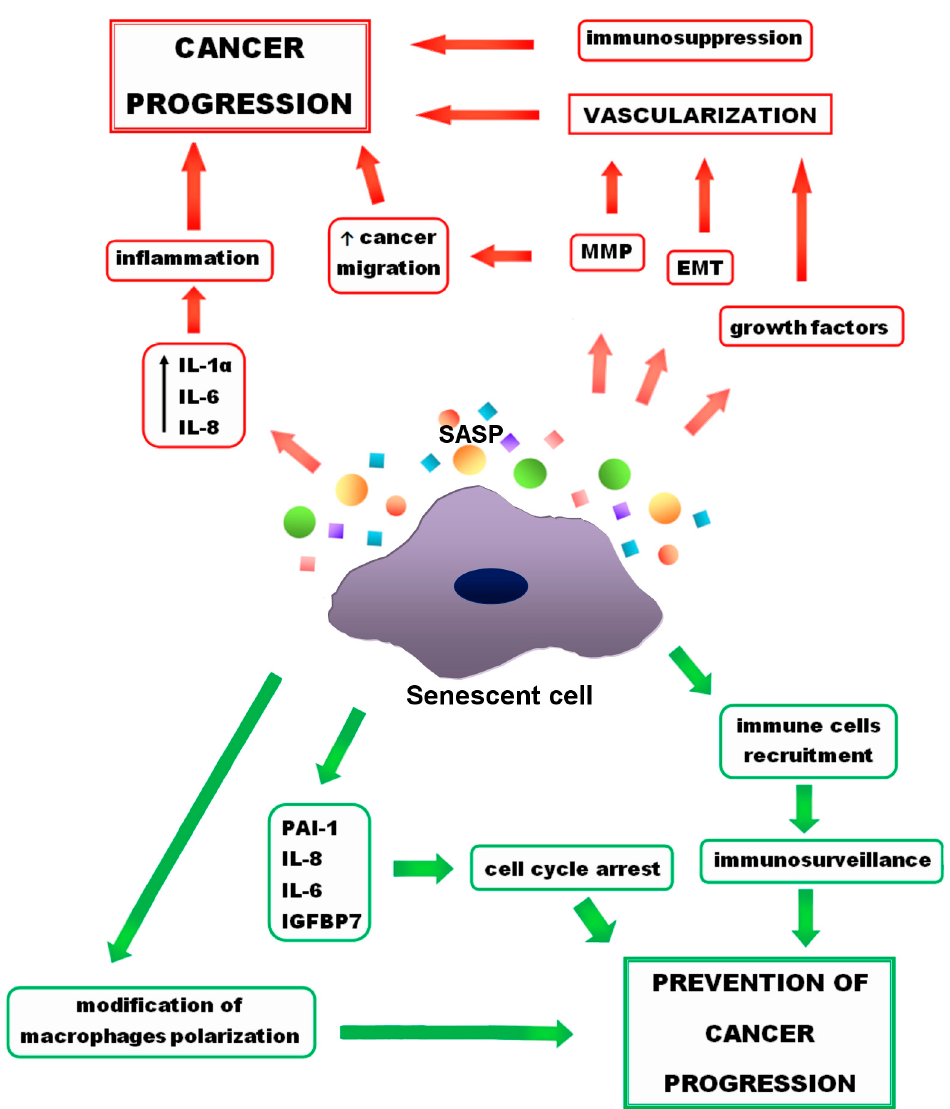
Figure 2. Positive (green arrows) and negative (red arrows) effects of senescence on cancer pro- gression. Growth factors and metalloproteinases (MMP), released by senescent cells, as well as epithelial-to-mesenchymal transformation (EMT) lead to the cancer vascularization. MMPs also support cancer migration. Other (SASP) components, such as interleukin 1 α (IL-1 α ), interleukin 6 (IL-6), interleukin 8 (IL-8) result in inflammation, which promotes cancer progression. On the other hand, senescence has also a preventive activity. Some of the SASP components, such as IL-6, IL-8, plasminogen activator inhibitor (PAI-1), insulin-like growth factor-binding protein 7